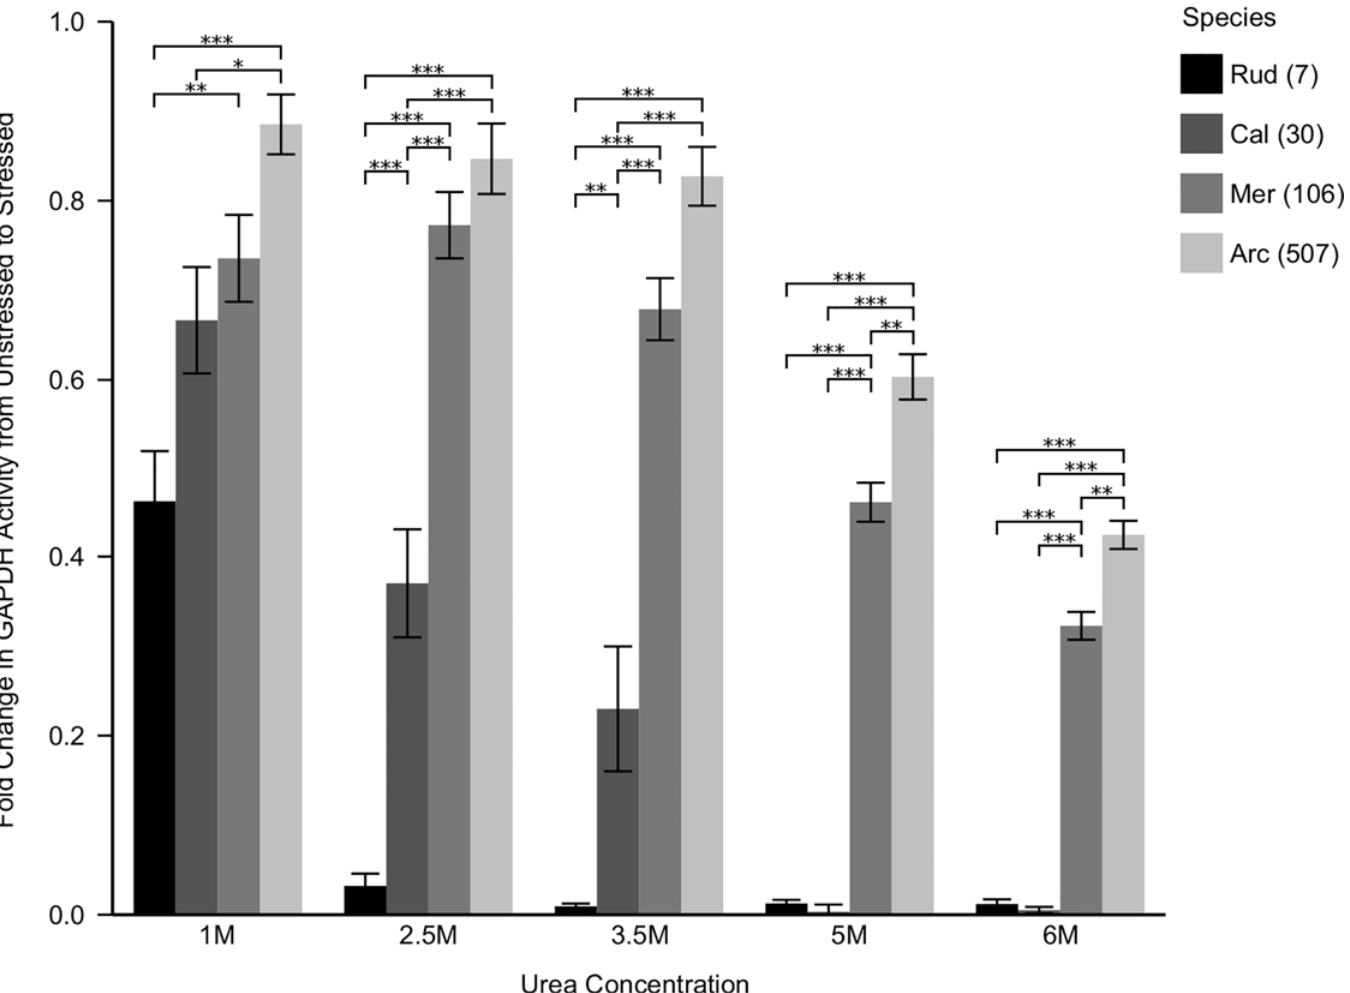
Fig 1. GAPDH Activity with Increasing Urea Stress in Bivalves. Lysates from each species were pre-stressed for twenty minutes in the noted urea concentrations. Glyceraldehyde 3-phosphate was then added, and the activity of endogenous GAPDH was monitored as Δ A 340 /minute, corresponding to the reduction of NAD + to NADH. Data is reported as the fold change from unstressed activity. Differences among species were assessed by two way analysis of variance indicating a significant main effect of species (F 3,60 = 23.7, p < 0.0001) stress (F 4,60 = 30.9, p < 0.0001), as well as the interaction between species and stress (F 12,60 = 10.2, p < 0.0001). Long-lived species maintain GAPDH function at all doses tested, while shorter-lived species were dramatically compromised. Asterisks indicate significant individual differences as assessed post hoc with Tukey's HSD, p < 0.05 ( * ), 0.001 ( ** ), and 0.0001 ( *** ), respectively. Rud = Ruditapes , Cal = Callista , Mer = Mercenaria , Arc = Arctica . Numbers in parentheses are maximum species longevity in